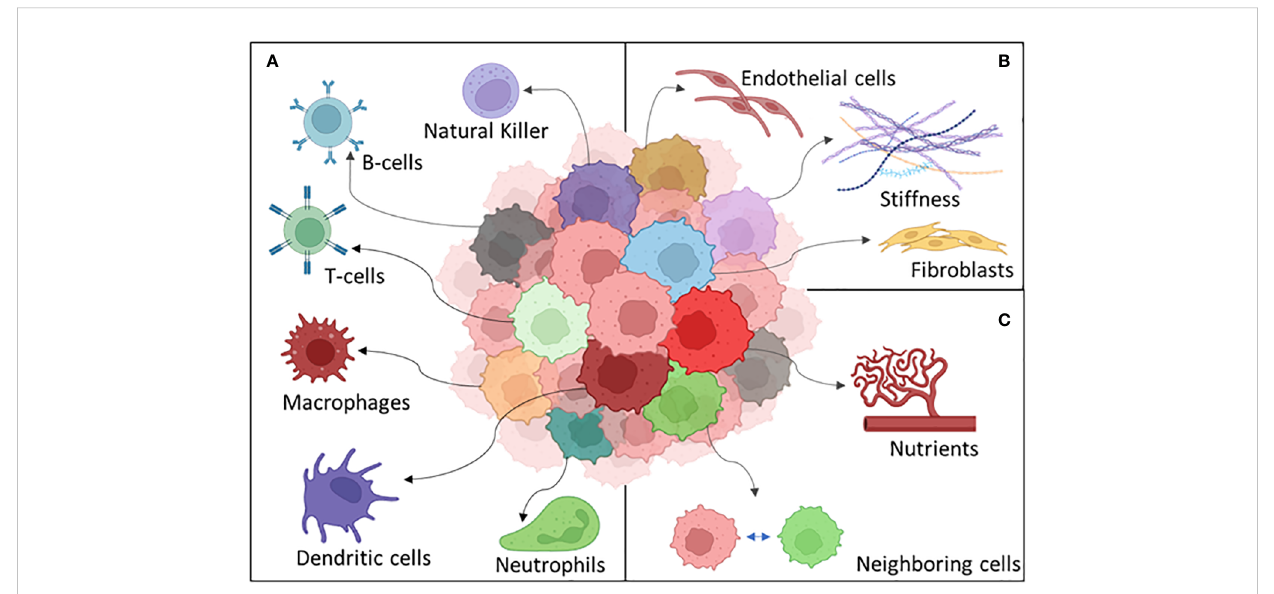
FIGURE 5 The different components of the tumor microenvironment: (A) the immune system, (B) stroma, and (C) external